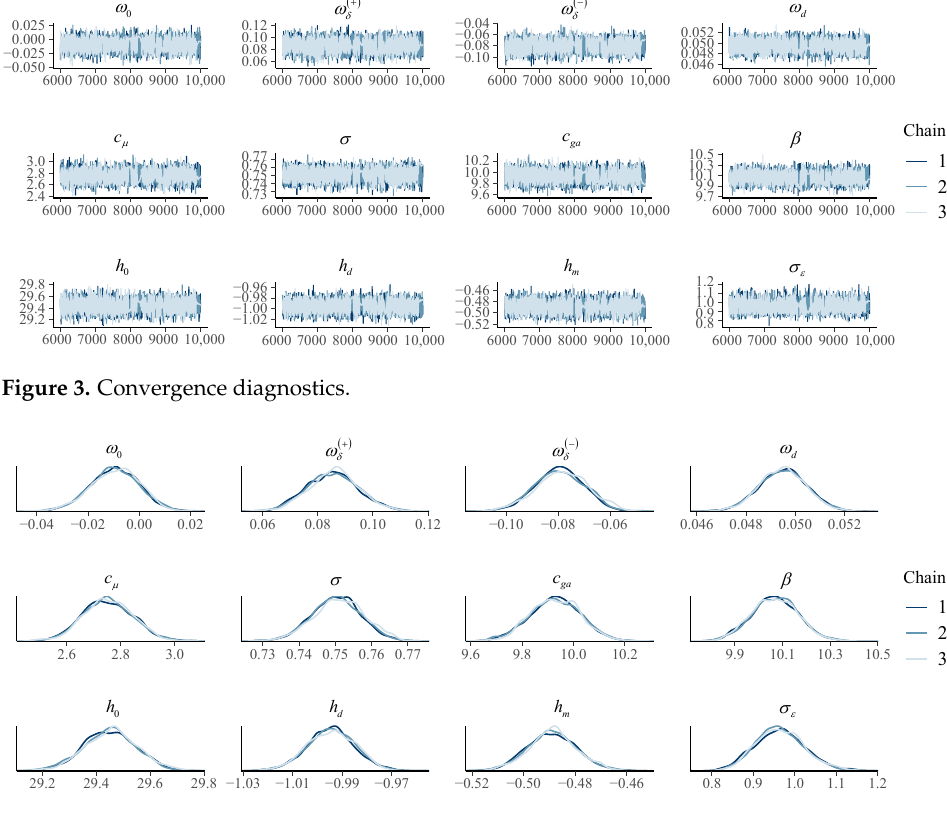
Figure 4. Bayesian parameter estimation. Figure 5 shows the prediction results of Settings 1 and 2. The black curves represent the true values of the observations, and the red curves represent the predictive values. The red point at time t i + 1 is predicted from the black points before time t i . The red band represents the 5% to 95% prediction interval. It can be seen that the red prediction interval almost covers the black curve, thus the predicted value matches the true value. The blue curves represent the physiological degradation processes D ( t ) , and the parameters c ga of Settings 1 and 2 are 10 and 5, respectively. The value of c ga in Setting 1 is larger, so it results in a faster monotonically increasing D ( t ) and, thus, a more significant decrease in the observations.